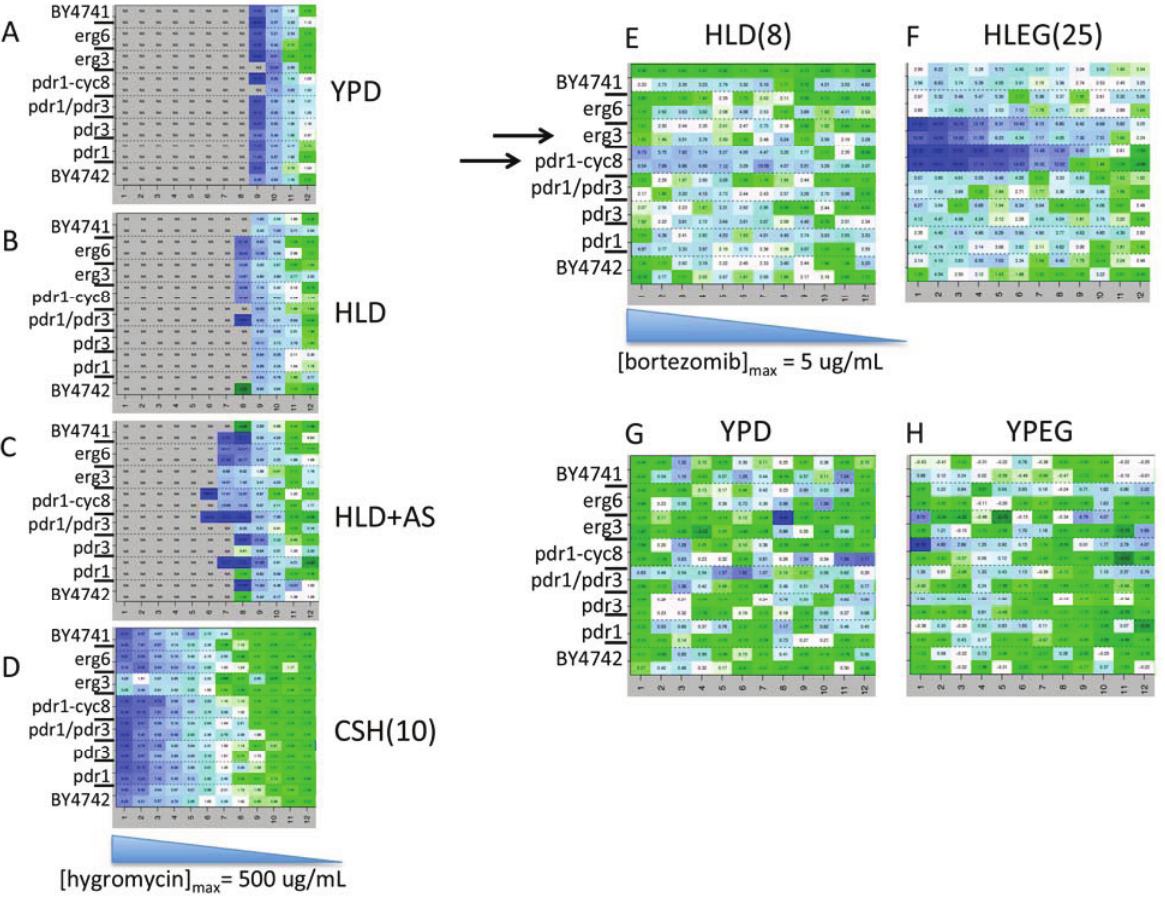
Figure 4. Drug sensitivity can depend upon media type, cellular efflux and permeability of drugs, or interaction between media and efflux or permeability. The experimental description is given in the text. The blue color scale indicates decreased fitness (increased L), with the range (hours) indicated in parentheses beside media type labels where relevant (panels E and F). Numerical interaction values are printed in each cell. Gray color indicates that no growth curve was observed (complete growth inhibition at the particular drug concentration). The cell array data was rearranged in the heat maps to assist visualization (rows 1/9, 2/10…8/16 were grouped). ( A – D ) Gradient plates were poured with 500 (cid:3)g/mL hygromycin in ( A ) YPD, ( B ) HLD, ( C ) HLD+AS, and ( D ) CSHD; ( E – H ) Gradient plates were poured with 5 μg/mL bortezomib in ( E ) HLD, ( F ) HLEG, ( G ) YPD, and ( H )